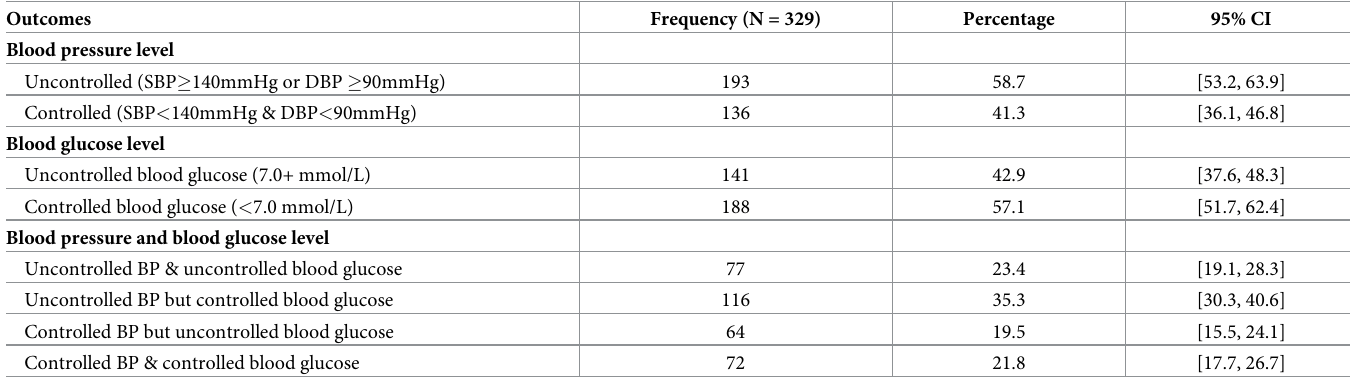
Table 2. Blood pressure and blood glucose levels.